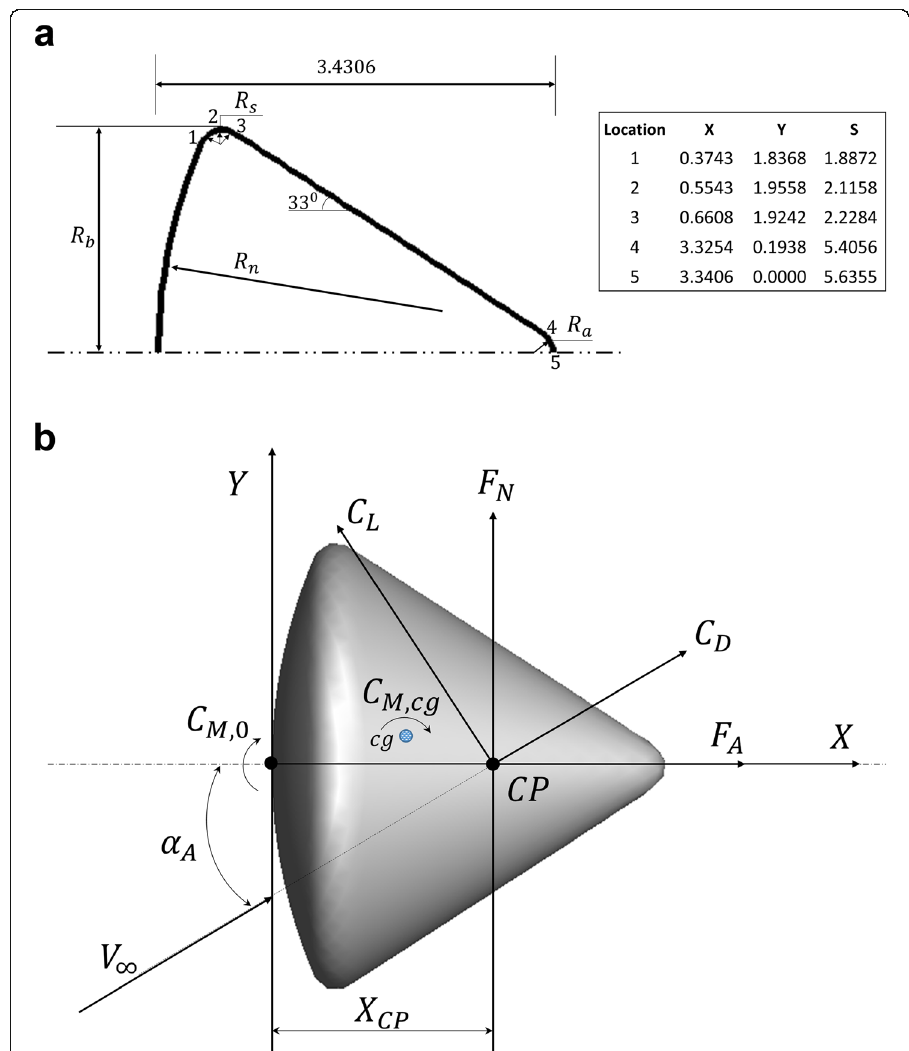
Fig. 2 Schematic view of an Apollo capsule: a outer mold line, and b aerodynamic forces and